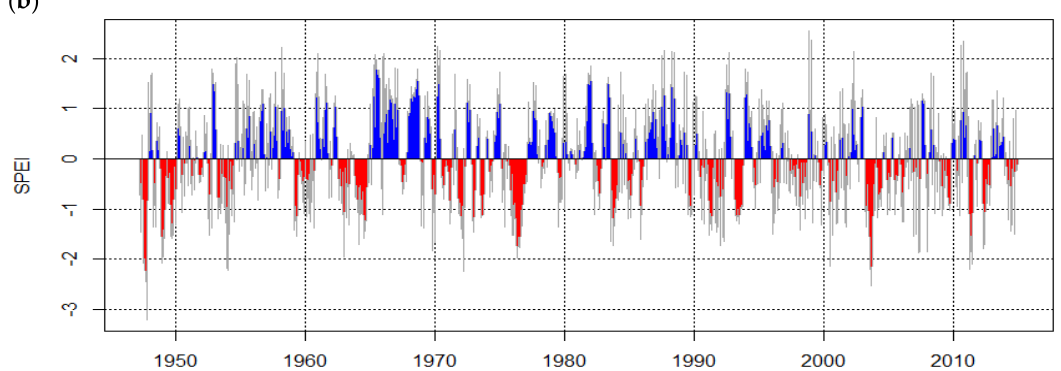
Figure 5. Calculated standard precipitation-evapotranspiration index (SPEI) for München ( a ) from 1955 to 2014 and Würzburg ( b ) from 1947 to 2014 with a time scale of four months. Blue-colored series represents positive SPEI values (>0) of years with a positive climatic water balance, and red-colored series represents negative SPEI (<0) values of a negative climatic water balance. Table 3. Linear mixed model on the annual growth rate (mm ¨ year ´ 1 ) during the last 20 years (1994–2013) of all analyzed trees (response variable) with the individual tree code as random effect and a random slope added for the effect of dbh, and fixed effects dbh, canopy openness, OSA, species, and water supply (measured with SPEI) of the form: Growth rate ij = β 1 ˆ x 1 ij + . . . + β n ˆ x nij + b i 1 ˆ z 1 ij + . . . + b in ˆ z nij + ε ij where the growth rate is the response variable for the j th of n i observations in the i th of M groups or clusters, β 1 , . . . , β n are the fixed-effect coefficients, which are identical for all groups, x 1 ij , . . . , x nij are the fixed-effect regressors for observation j in group i ; the first regressor is usually for the constant, x 1 ij ´ 1 , b i 1 , . . . b in are the random-effect coefficients for group i , z 1 ij , . . . , z